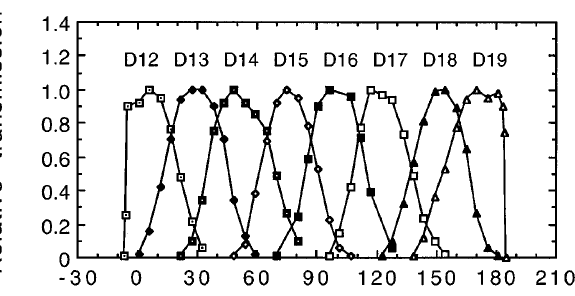
Fig. 3. Calibrated relative transmission of the MEPS detectors as a function of incidence angle with respect to the satellite spin